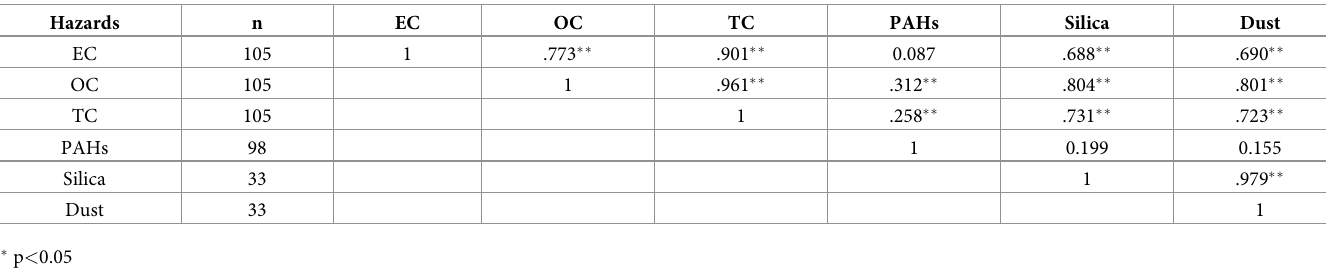
Table 7. Spearman’s rank correlation of hazardous substances; EC, OC, TC, PAHs, silica and dust. Hazards